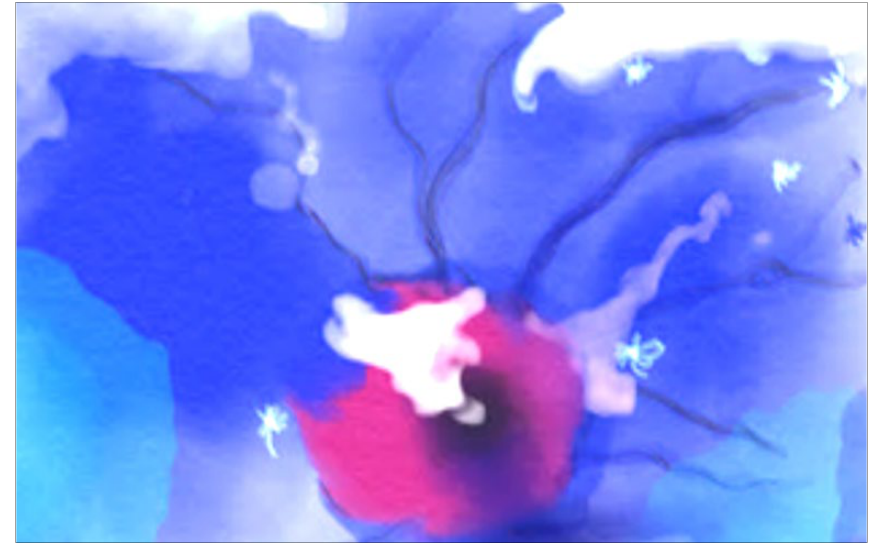
Figure 7. Circling back: Turning Cancer into